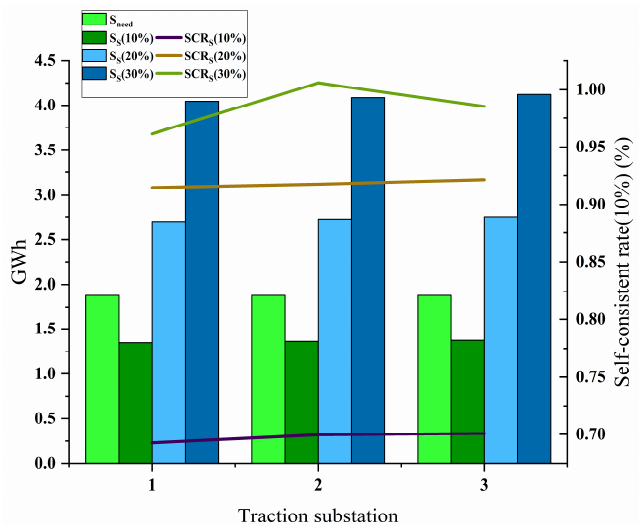
Figure 10. Electricity purchase, electricity sales and emission reduction under three development intensity.